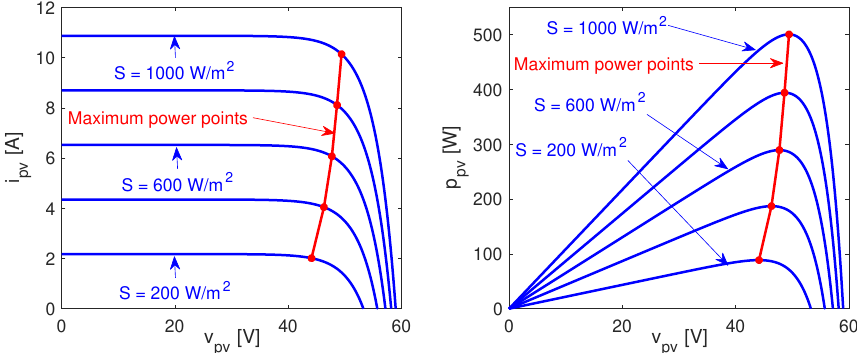
Figure 8. Electrical characteristics of the SP500M6-96 PV